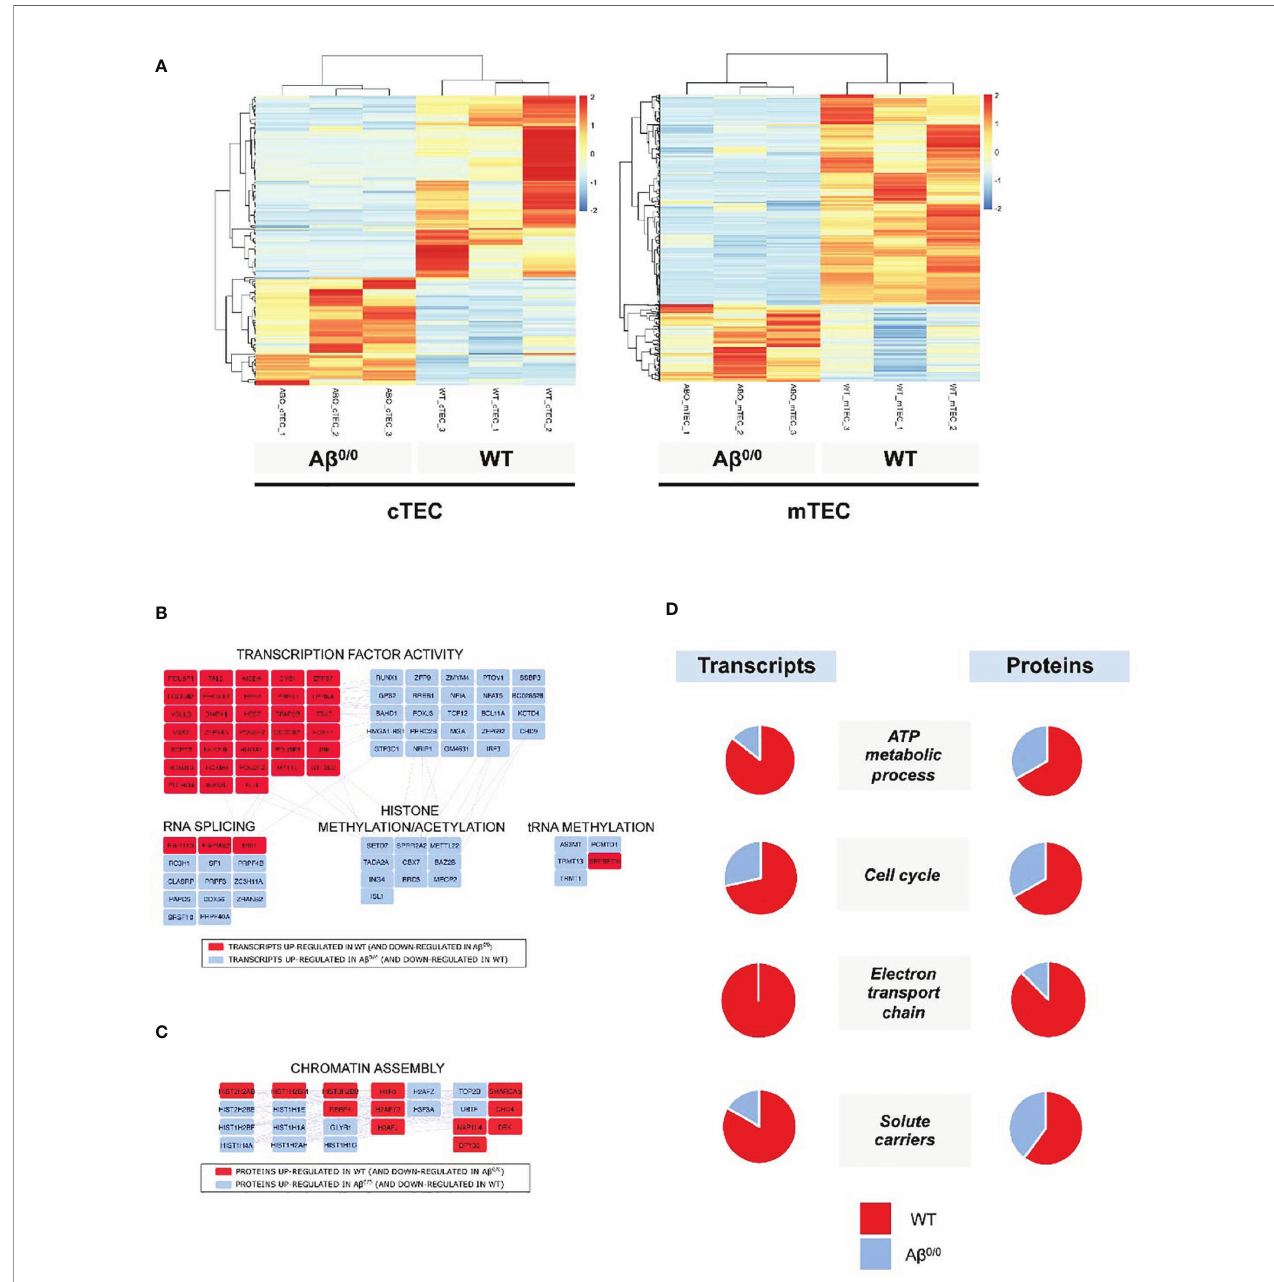
FIGURE 4 | Transcriptome and proteome perturbation in absence of MHCII molecules. (A) Heat map of expression values for genes that were differentially expressed between A b 0/0 and WT mice cTEC or mTEC at a p value cut-off (FDR-corrected) of 0.05. Rows (genes) are scaled, i.e., the value (z score) for a gene in a given sample represents its deviation from the mean expression value of the gene across all samples in terms of standard deviations. Up regulation is shown in red, down regulation in blue. Genes and samples are ordered by hierarchical clustering using Pearson ’ s correlation as the distance measure and complete linkage as the clustering method. (B) Network analysis of differentially expressed transcripts in mTEC. The fi gure shows the main results of network/topology analysis based on the combination of the list of DE transcripts in mTEC with Mus musculus Protein – Protein Interaction (PPI) network using STRING bioinformatics tool (full fi gure is reported in Supplementary Figure 4A ). In red are represented transcripts up-regulated in WT mTEC, in light blue those up-regulated in A b 0/0 mTEC. (C) Cluster-Network analysis of differentially expressed proteins in CD45-depleted TEC fractions. The fi gure shows the main results of network/topology analysis based on the combination of the list of DE proteins in CD45-depleted TEC fractions with Mus musculus Protein – Protein Interaction (PPI) network using STRING bioinformatics tool (full fi gure is reported in Supplementary Figure 4B ). In red are represented proteins up-regulated in WT mice, in light blue those up-regulated in A b 0/0 mice. (D) Transcript and protein expression per functional cluster in WT and A b 0/0 cell subsets. For each cluster, the proportion of enriched transcripts or proteins in WT (red) or A b 0/0 (blue) are represented as percentage in the respective pie charts. Data about transcripts were obtained from sorted mTEC, data about proteins were obtained from CD45-depleted TEC